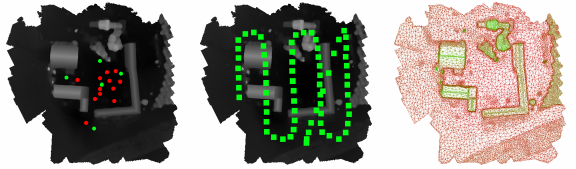
Figure 16. The UAV acquisition (Case 2). From the left: Distribution of GCPs (green) & CPs (red), acquisition protocal, initial mesh (from result of method 1) generated by MicMac.